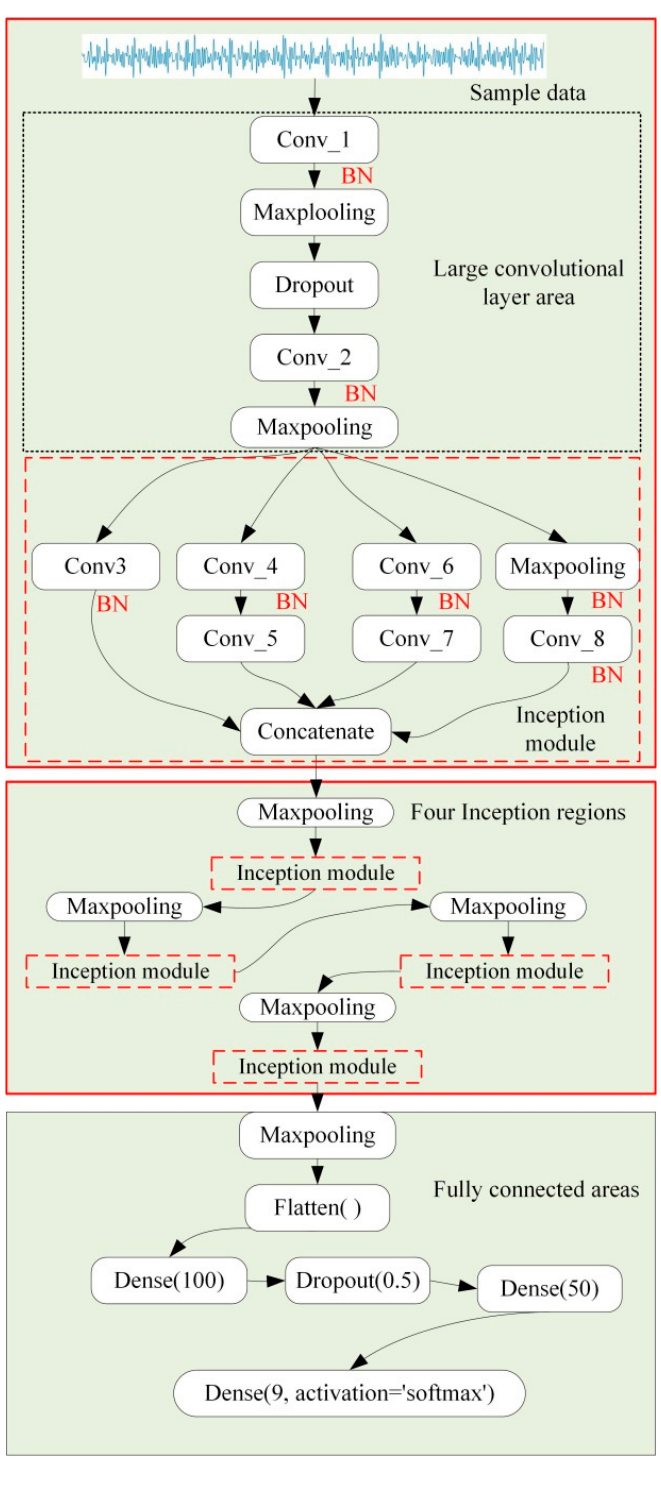
Figure 3. Structure of BICNN.